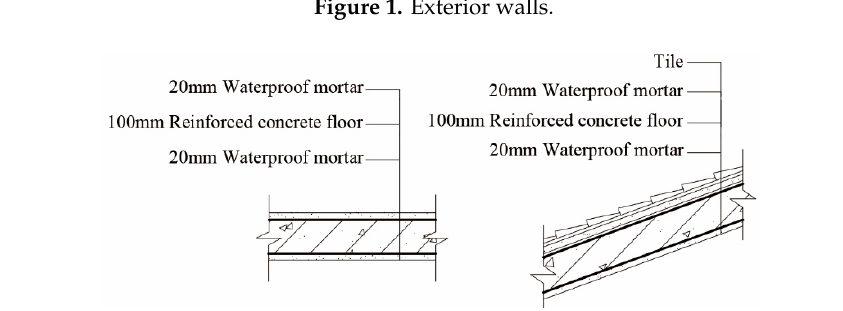
Figure 2. Roofs. Figure 2. Roofs.